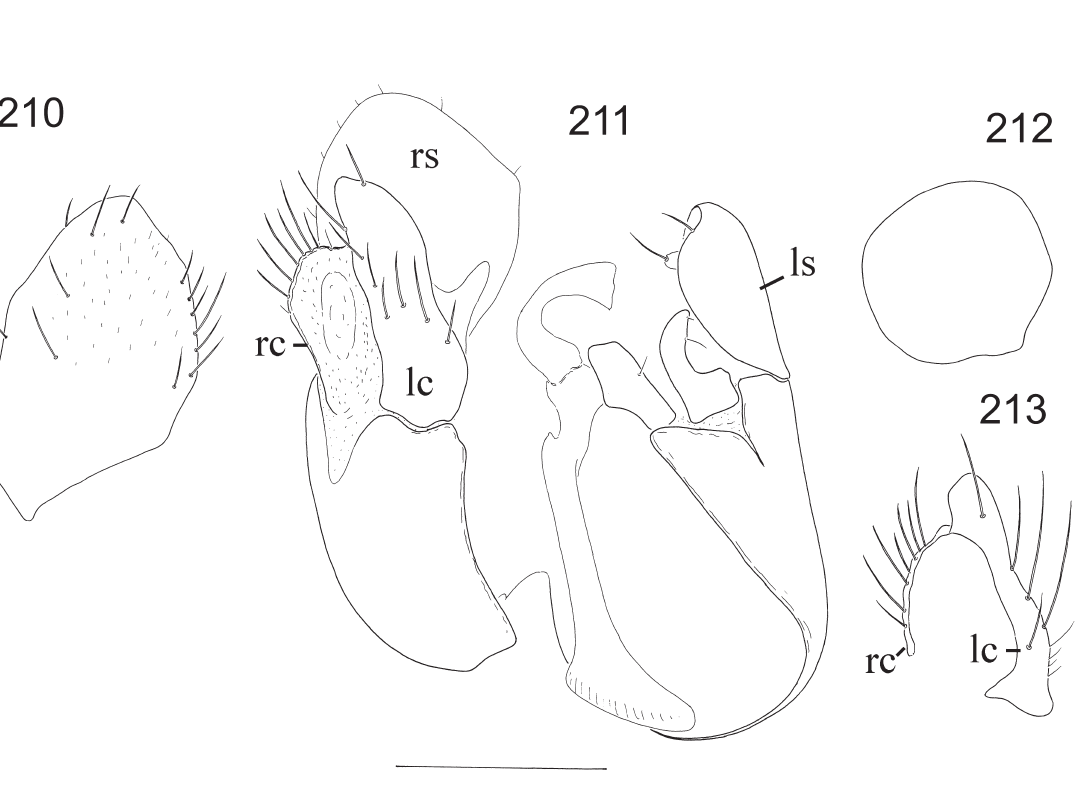
Figs 210-213. Stilpon laawae , Shamshev & Grootaert, 2004, ♂ terminalia (Material Singapore). 210 . right surstylus, dorsal view. 211 . epandrium with cerci, dorsal view. 212 . left surstylus, lateral view. 213 . cerci, right lateral view. Scale bar= 0.1